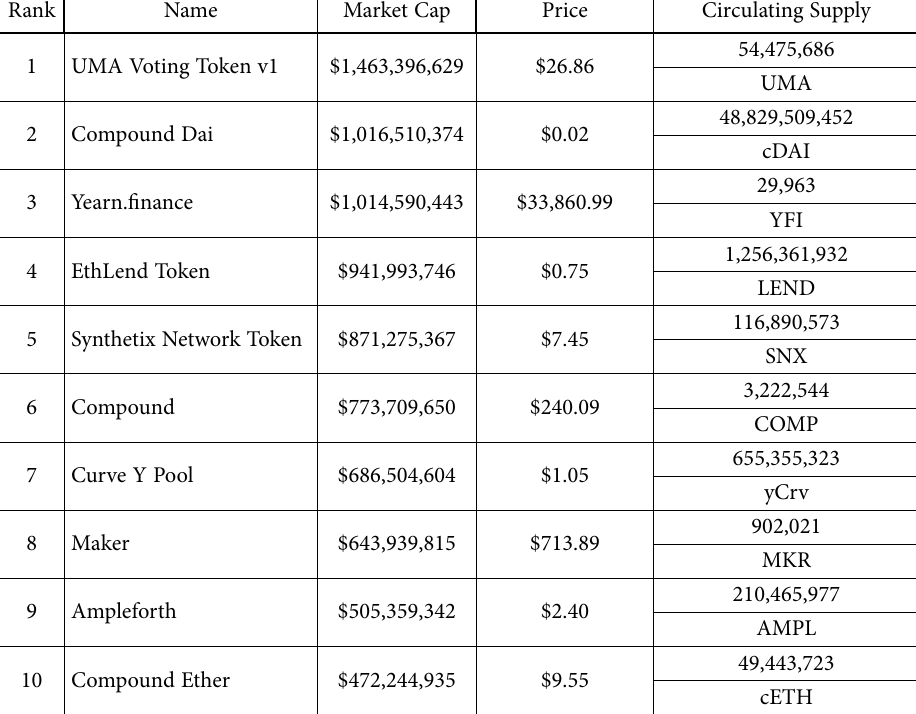
Table 2. The top 10 on market capitals of cryptocurrencies in 2020 (source: DeFi Market Cap,